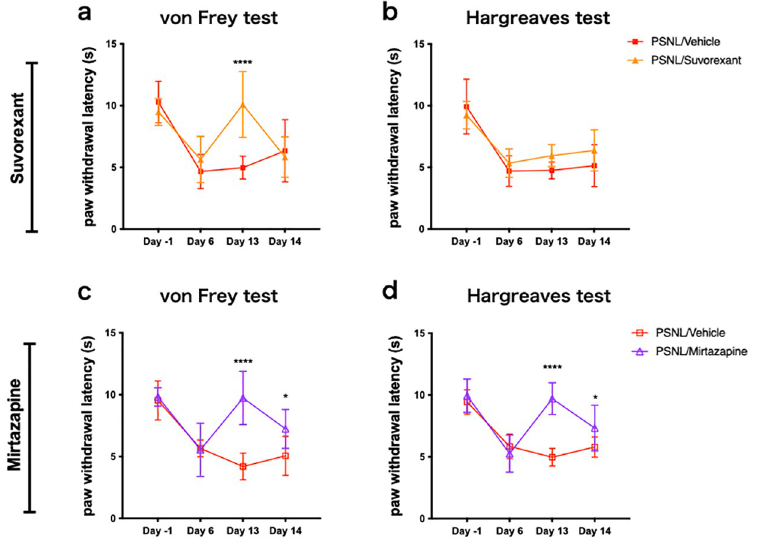
Fig 2. Suvorexant and mirtazapine improved mechanical allodynia and thermal hyperalgesia in the neuropathic pain model. They were assessed for mechanical allodynia (a, c) and thermal hyperalgesia (b, d) with four test points, with the automated von Frey and Hargreaves tests. Data are expressed as means ± SEMs (PSNL-vehicle, n = 8–9; PSNL-suvorexant, n = 8; PSNL-mirtazapine, n = 9). � P < 0.05, ���� P < 0.0001, compared by two-way ANOVA with Bonferroni post-test. Abbreviations: ANOVA, analysis of variance; PSNL, partial sciatic nerve ligation; SEM, standard error of the mean; ZT, Zeitgeber time.